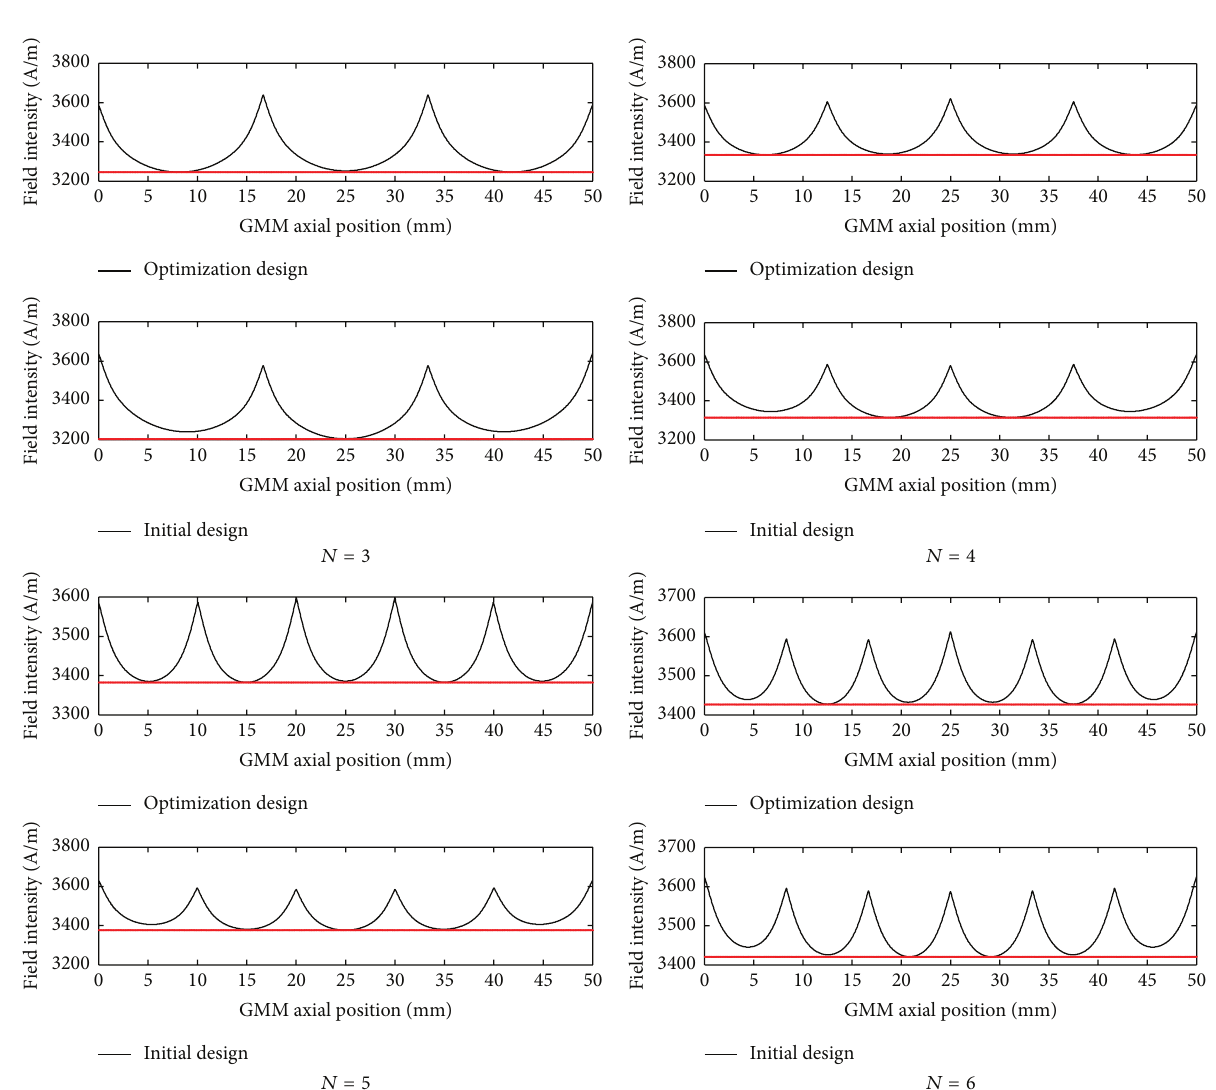
Figure 13: Axial field distribution before and after